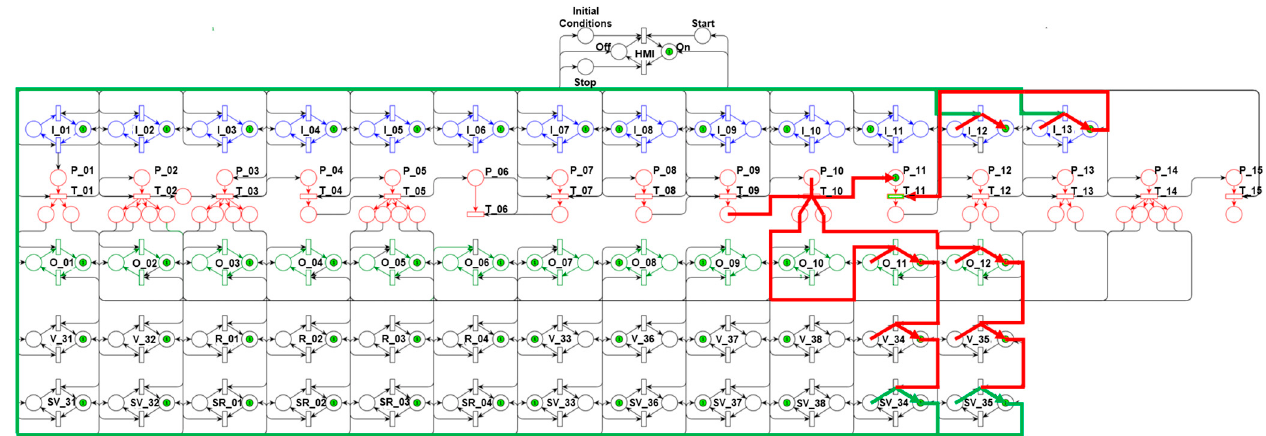
Figure 30. Algorithm’s 12th step—Open valves.